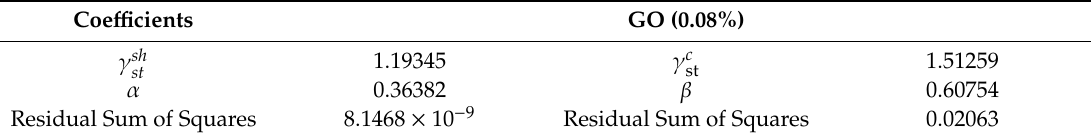
Table 10. Influential and exponential coefficients (concrete containing 0.08% GO nanosheets by weight of cement).